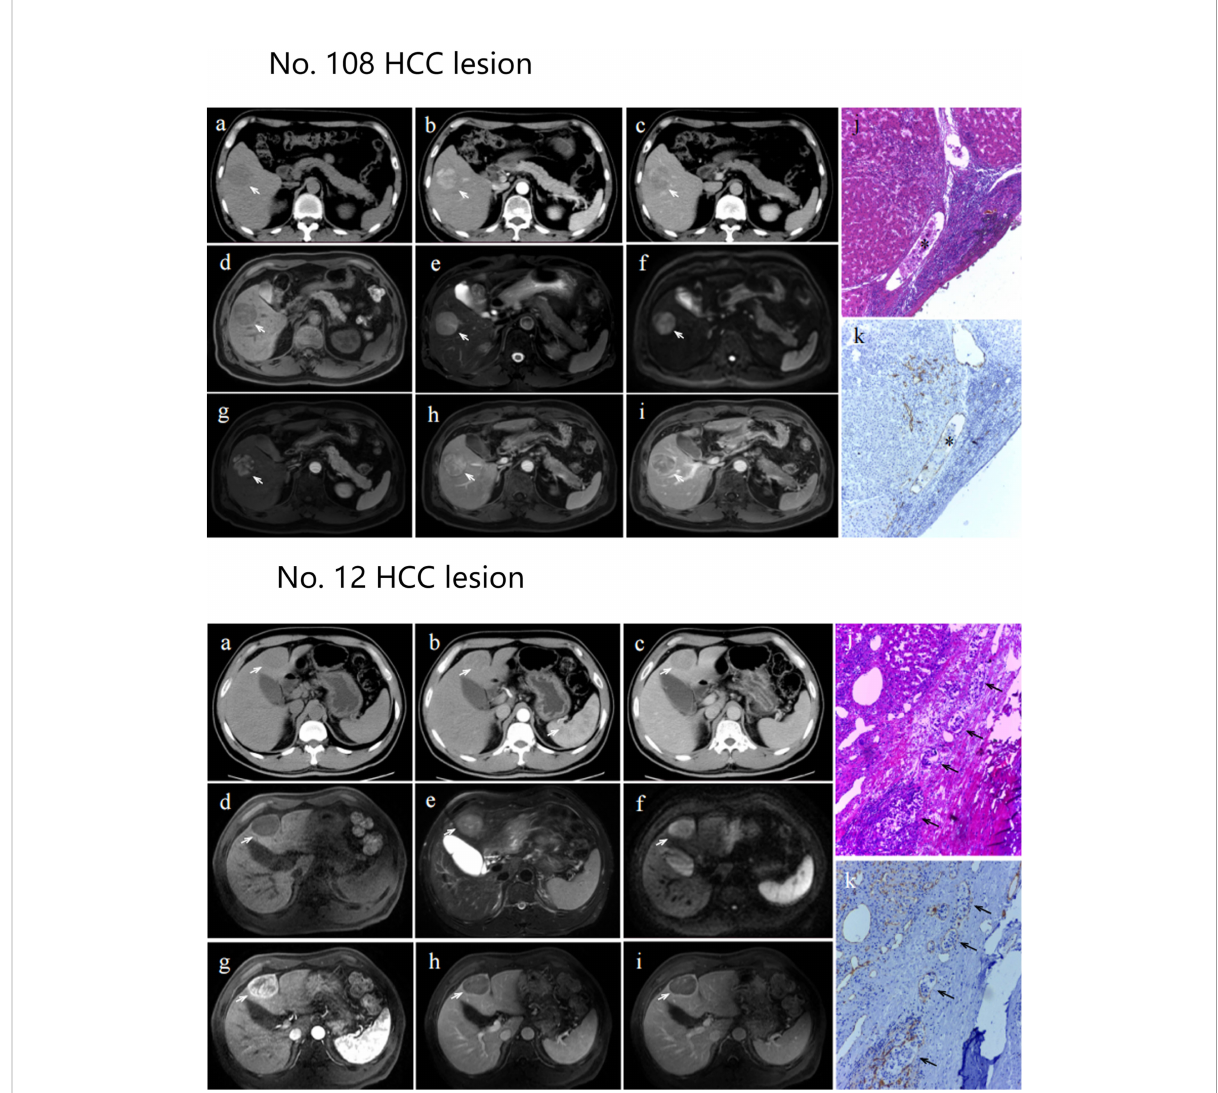
FIGURE 6 Axial CT images, axial MRI images and pathological section maps of No. 108 and No. 12 HCC lesion Axial CT images (A) : plain scan; (B) : arterial phase; (C) : portal venous phase) and axial MRI images (D) : T1-weighted imaging; (E) : T2-weighted imaging; (F) : diffusion weighted imaging; g: arterial phase; (H) : portal venous phase; (I) : venous phase. The lesion is indicated by a white arrow. Pathological section maps with HE staining (J) and CD31 staining (K) showed positive microvascular invasion, as indicated by black asterisks or black